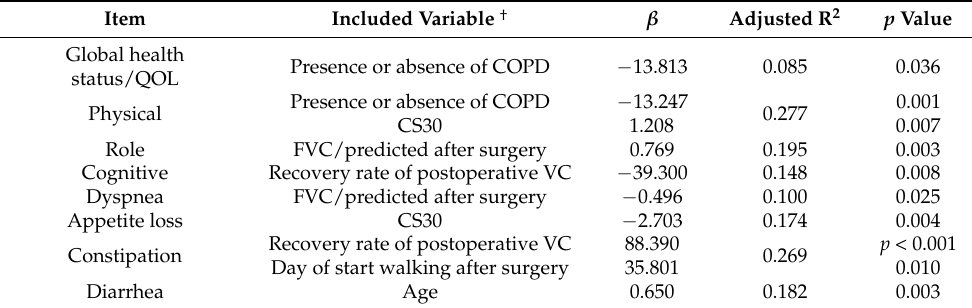
Table 4. Results of stepwise multiple regression